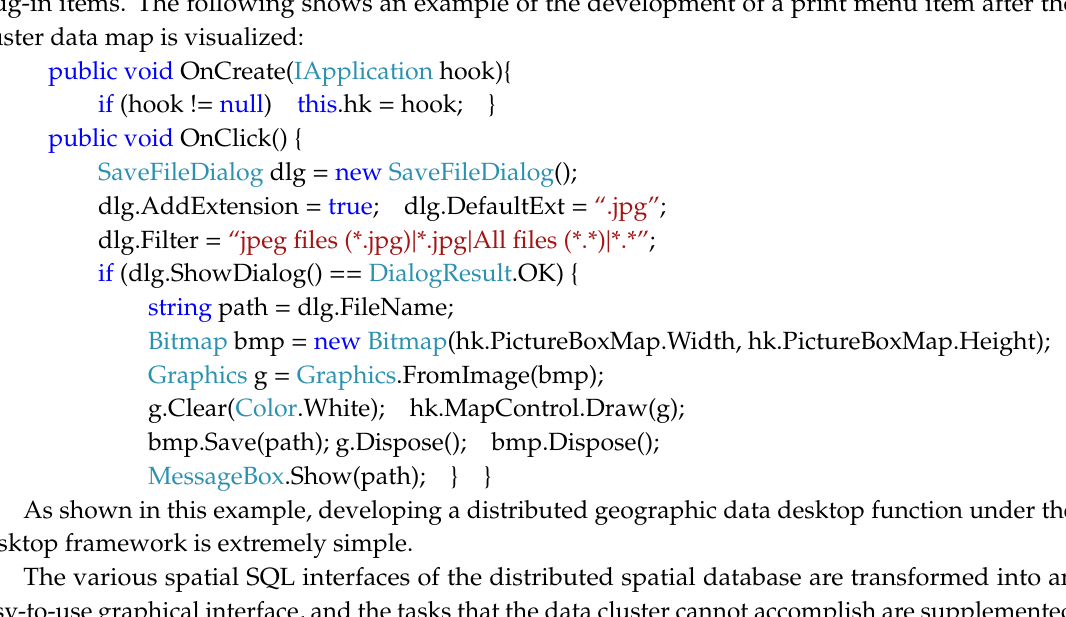
Figure 6. Desktop main interface. The main interface of Desktop includes menus, toolbars, status bars, layer windows, file directory windows, and map views. The current map shows an image of the province’s service superimposed over administrative division vector data, and an administrative district selected to display and analyze its geometric structure.